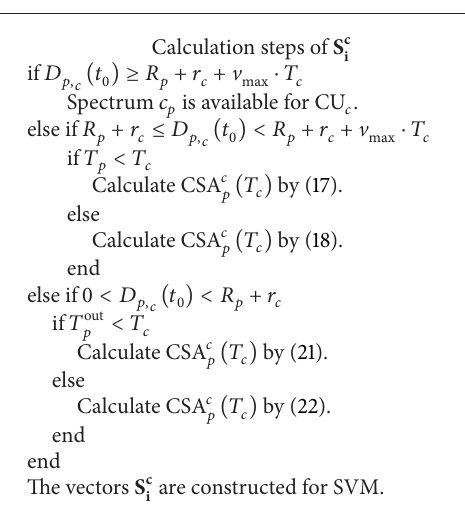
Algorithm 1: Joint feature vectors extraction for CU 𝑐 .